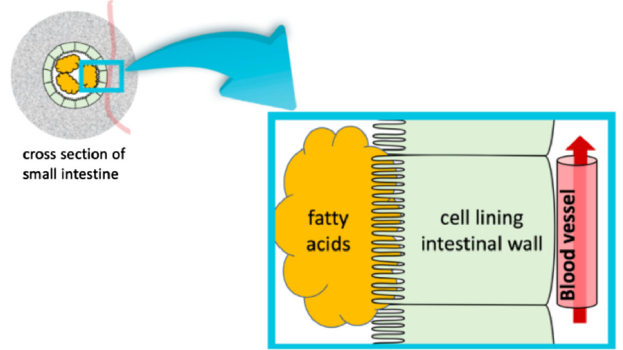
FIG. 1. The biological context for the diffusion task. Fatty acid molecules diffuse from the lumen of the small intestine to a blood vessel in the intestinal wall, via a cell lining the intestinal wall. Students were asked to plot the fatty acid concentration as a function of position between the intestine and the blood vessel, and to make qualitative and quantitative predictions about the rate of diffusion. The full task can be found in the Supplemental Material